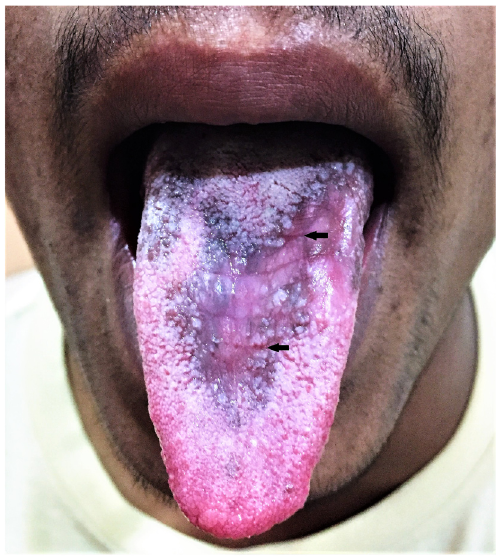
Figure 1. Dorsum of the tongue revealing violaceous to dark grey discoloration and blunted papillae in the centre with few tiny bright red erosions (black arrow) and interspersed white reticular